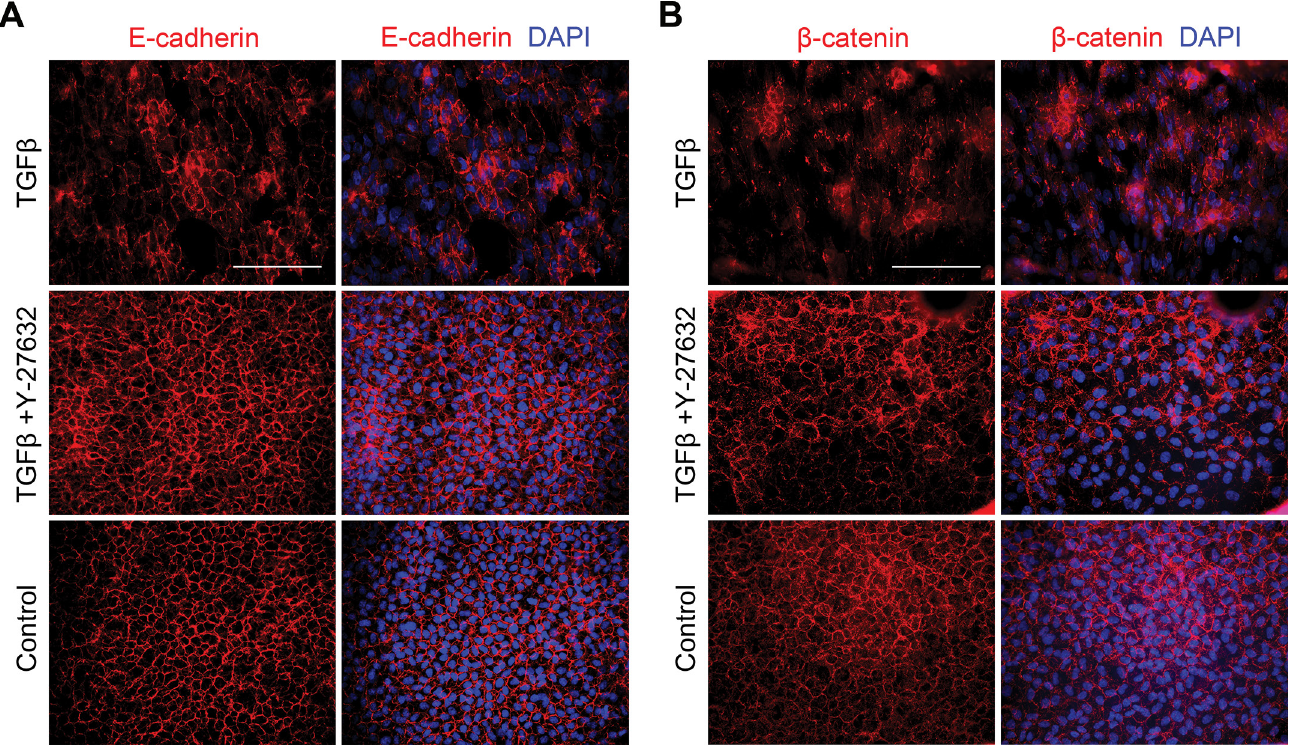
Figure 3. Y-27632 prevents TGF β -induced E-cadherin and β -catenin delocalization from the cell membrane. Lens explants (n ≥ 5 per treat- ment) were fixed and costained for (A) E-cadherin and α SMA or (B) β -catenin and α SMA following TGF β (4 ng/mL) treatment in the pres- ence and absence of Y-27632 after 48 h. All explants were mounted in medium with DAPI to colocalize nuclei. Scale bar = 100 μ m